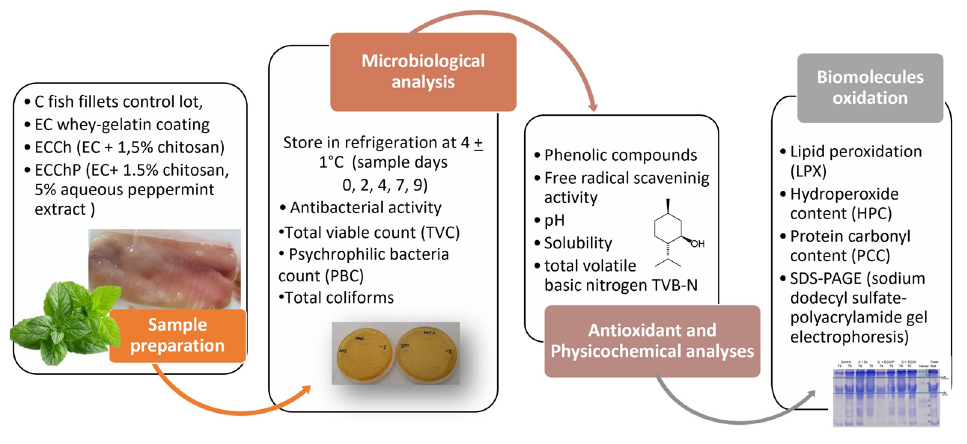
Figure 1. Representation of methodology.